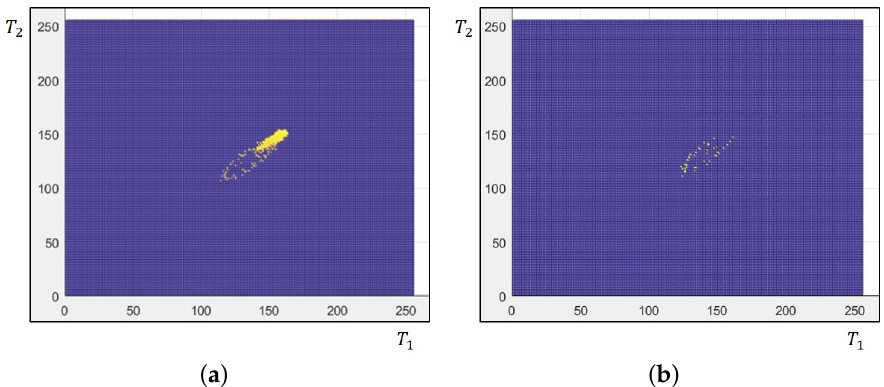
Figure 12. Color mapping matrices: ( a ) CMM and ( b ) local points without corresponding pixels in the initially aligned reference